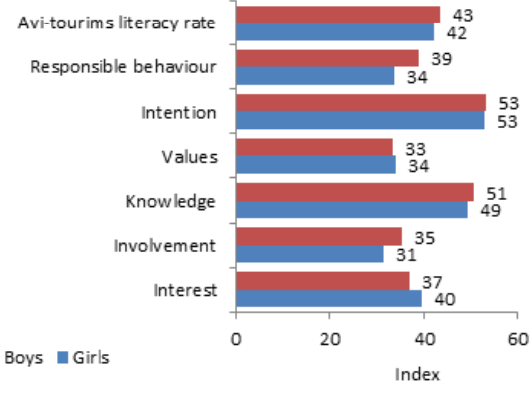
Figure 2: Avi-tourism literacy rates by gender